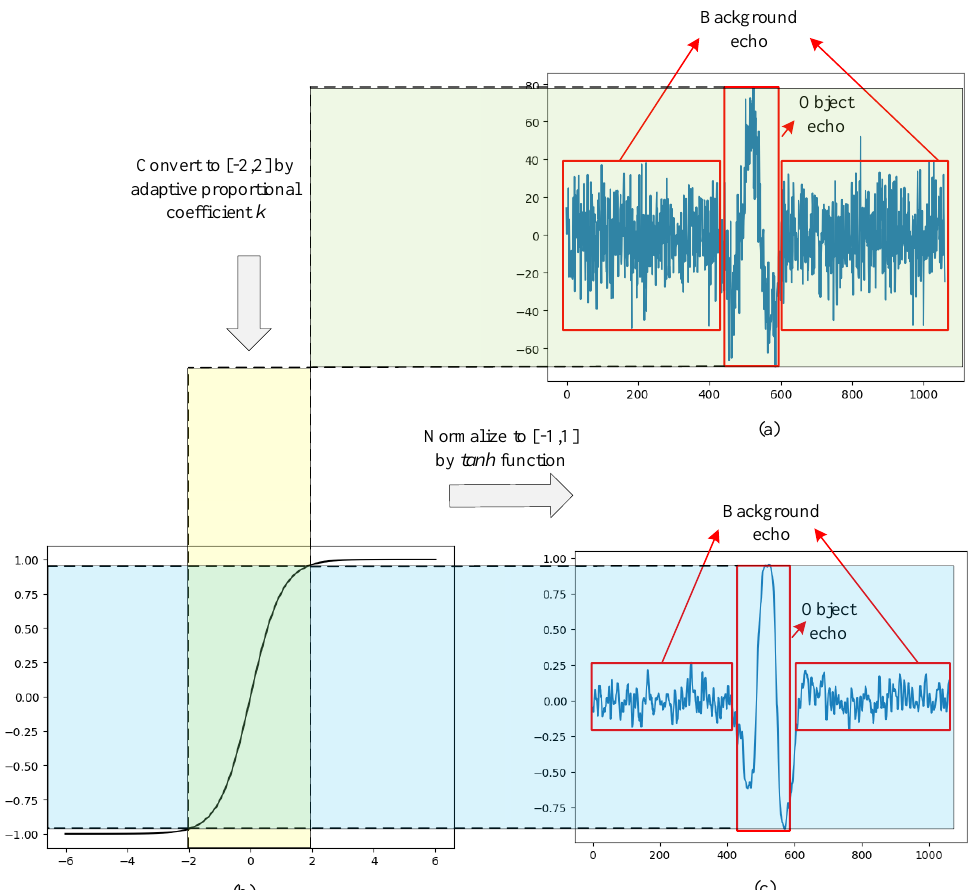
Figure 4. Adaptive normalization: ( a ) GPR A-scan signal with noise, ( b ) Tanh function curve, ( c ) GPR A-scan signal after the adaptive normalization.